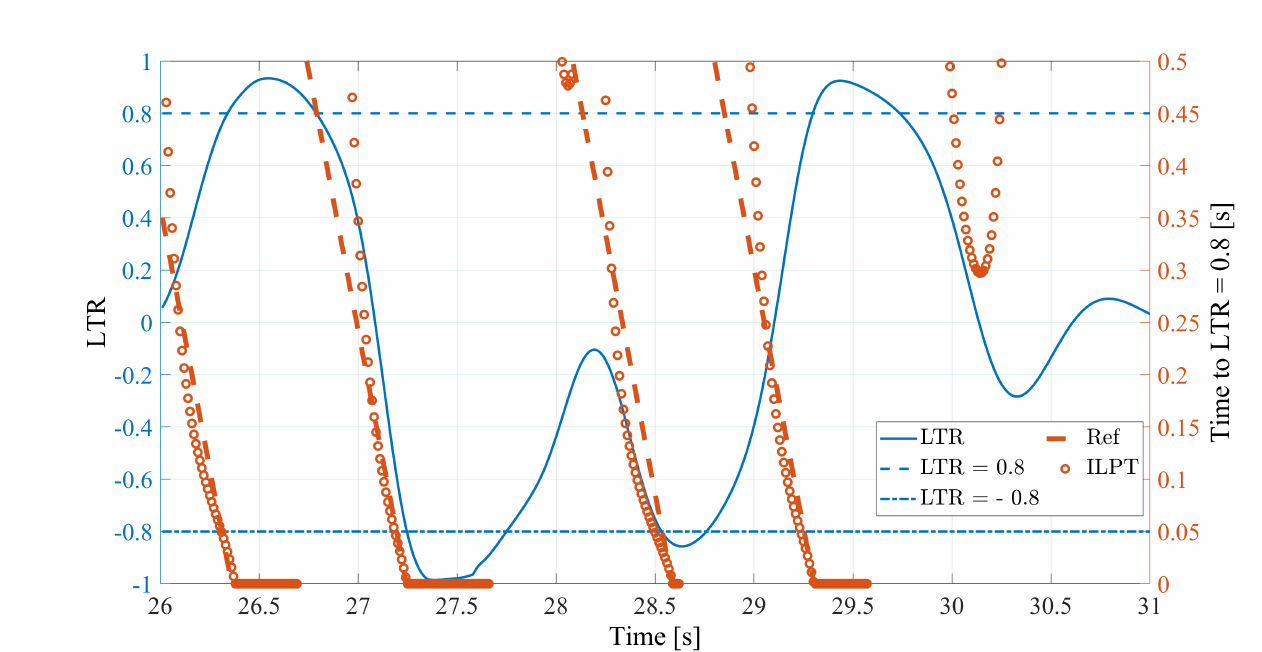
Figure 14. Double lane change manoeuvre at initial speed of 100km/h on a flat road: LTR , reference ( T Ref ) and estimated ( ILTP ) time to reach LTR =